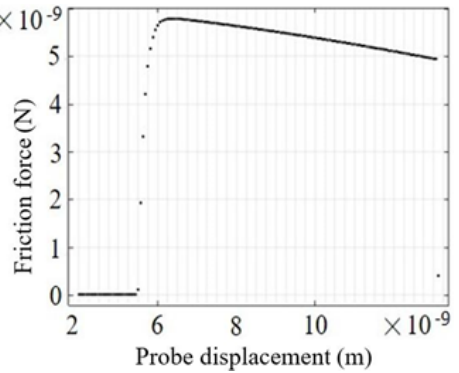
Figure 3. The curve of friction between the nanoparticle and sub- strate.